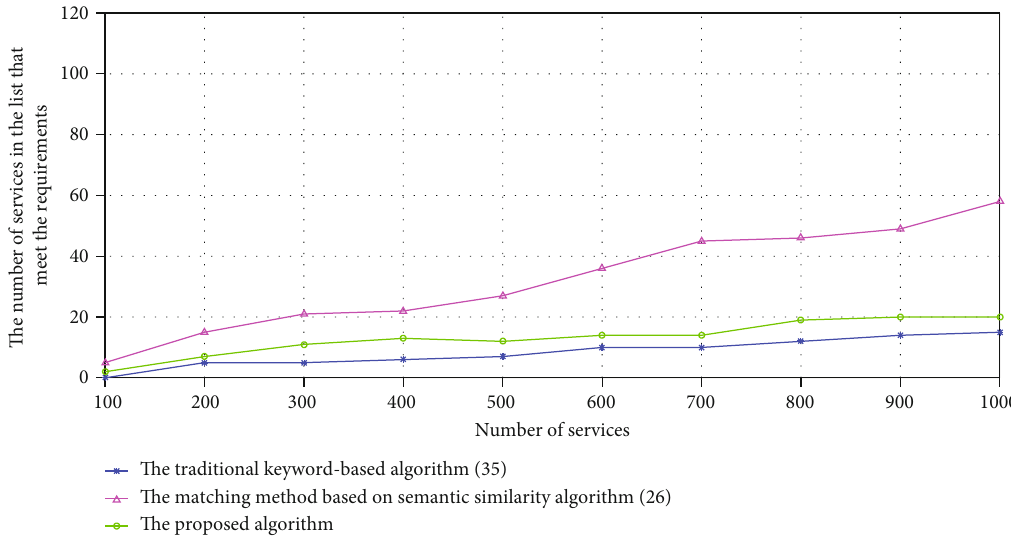
Figure 7: The number of services in the list that meet the requirements as the number of services